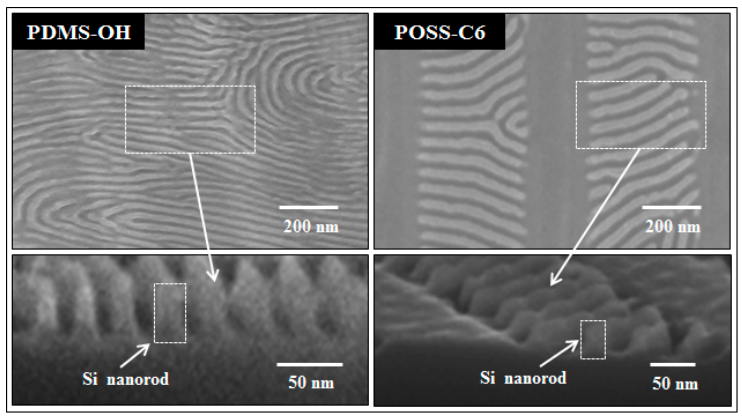
Figure 4. Top-down and high-resolution cross-section SEM images of PDMS patterns transferred to brush modified planar substrates and POSS-C6 patterned silicon substrates.